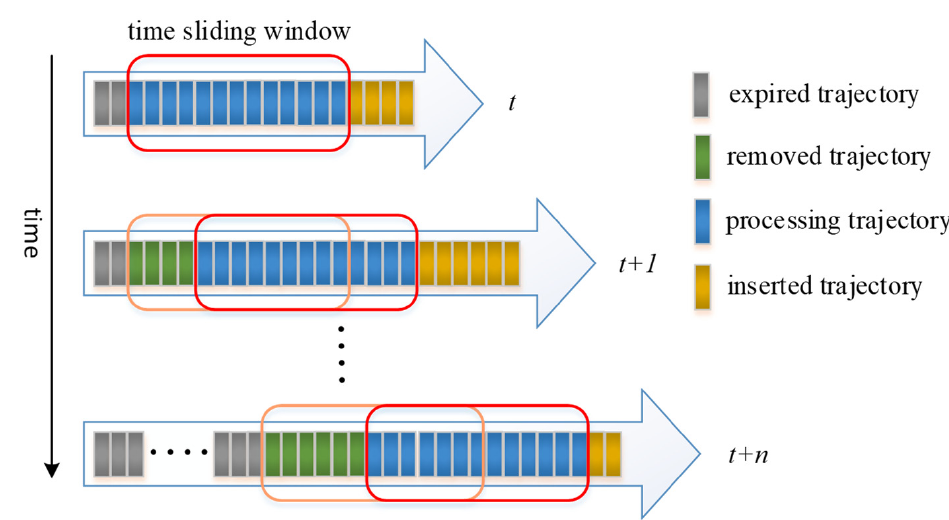
Figure 6. Continuous trajectories stream using sliding window model. Each cell represents a trajectory. The gray cells are the expired trajectories that have been removed from the cluster. The green cells are the removed trajectories that will be removed from the current cluster. The blue cells are the processing trajectories that have been absorbed to the current cluster. The yellow cell are the inserted trajectories that will be absorbed to the current cluster. The width of the sliding window represents the length of time. Trajectories within the sliding window are the dataset to generate the current cluster.